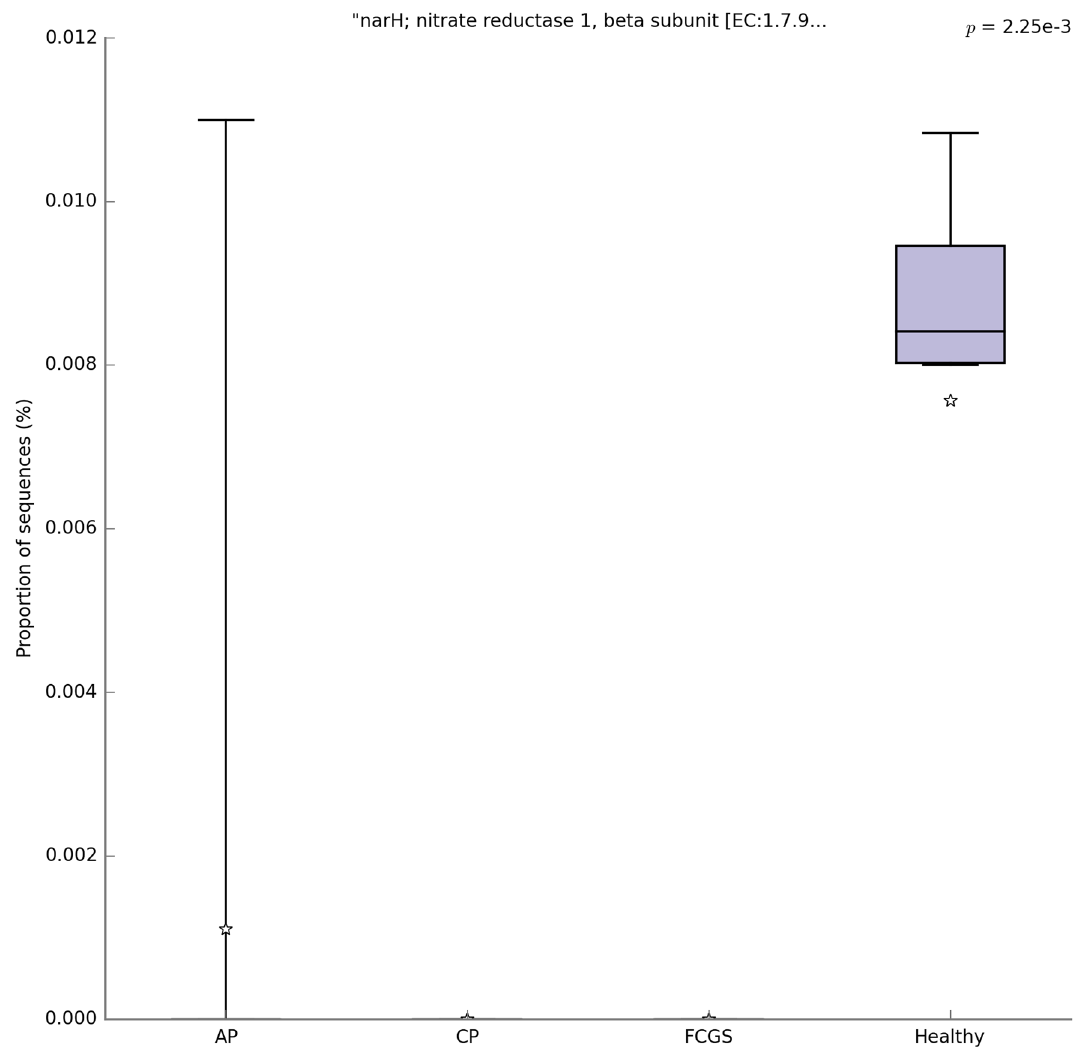
Figure 5. Box and whiskers plots illustrating the mean (star), median (line within the box), quartiles (IQR; 75th to 25th of the data), maximum and minimum (whiskers extend to the most extreme value) proportion of sequences (%) of the gene found with significant statistical difference in the metagenomic datasets studied (false discovery rate, FDR P -value < 0.05). The results were filtered using a P -value of 0.05; the data was computed using the MG-Rast metagenomics analysis server using KEGG Orthology (KO) database. This figure was generated using STAMP v2.1.3 (Statistical Analysis of Metagenomic Profiles) software (https:// beiko lab. cs. dal. ca/ softw are/